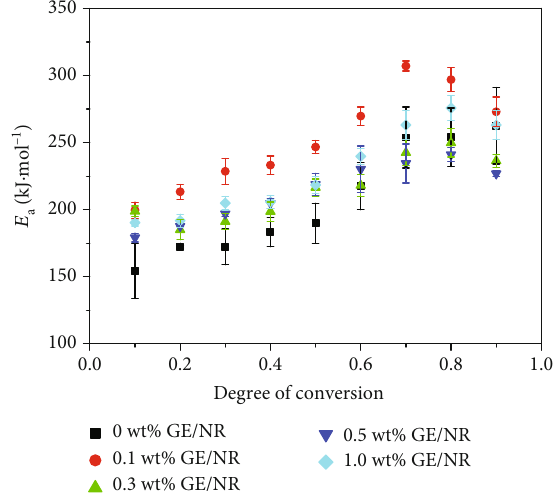
Figure 5: E a derived by the Friedman method as a function of conversion for samples of di ff erent GE